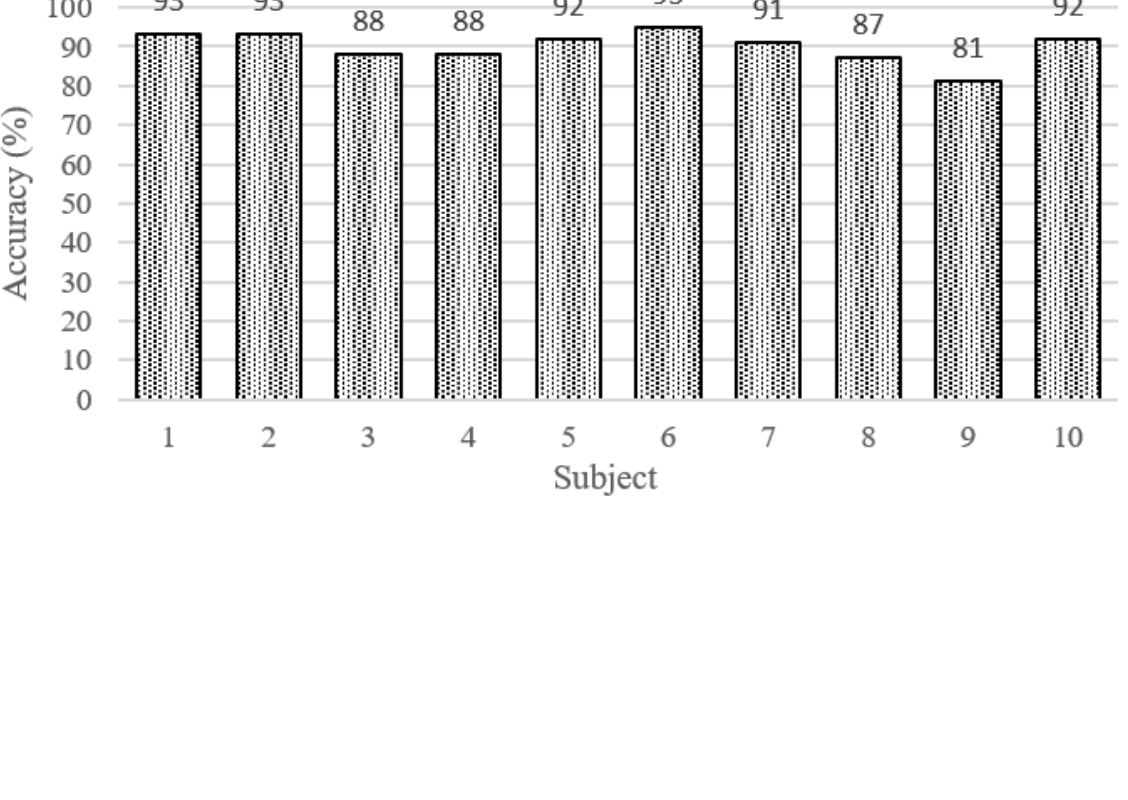
Figure 3. Average accuracy of the automatic speech detection system with respect to 10 teachers in a controlled